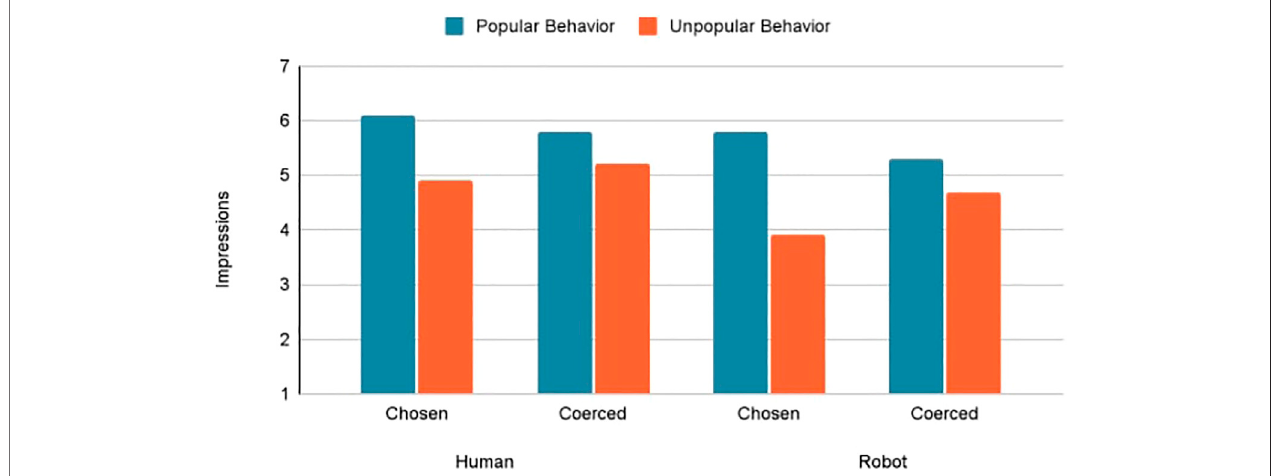
FIGURE 4 | Simple main effects of choice and behavior on impressions of